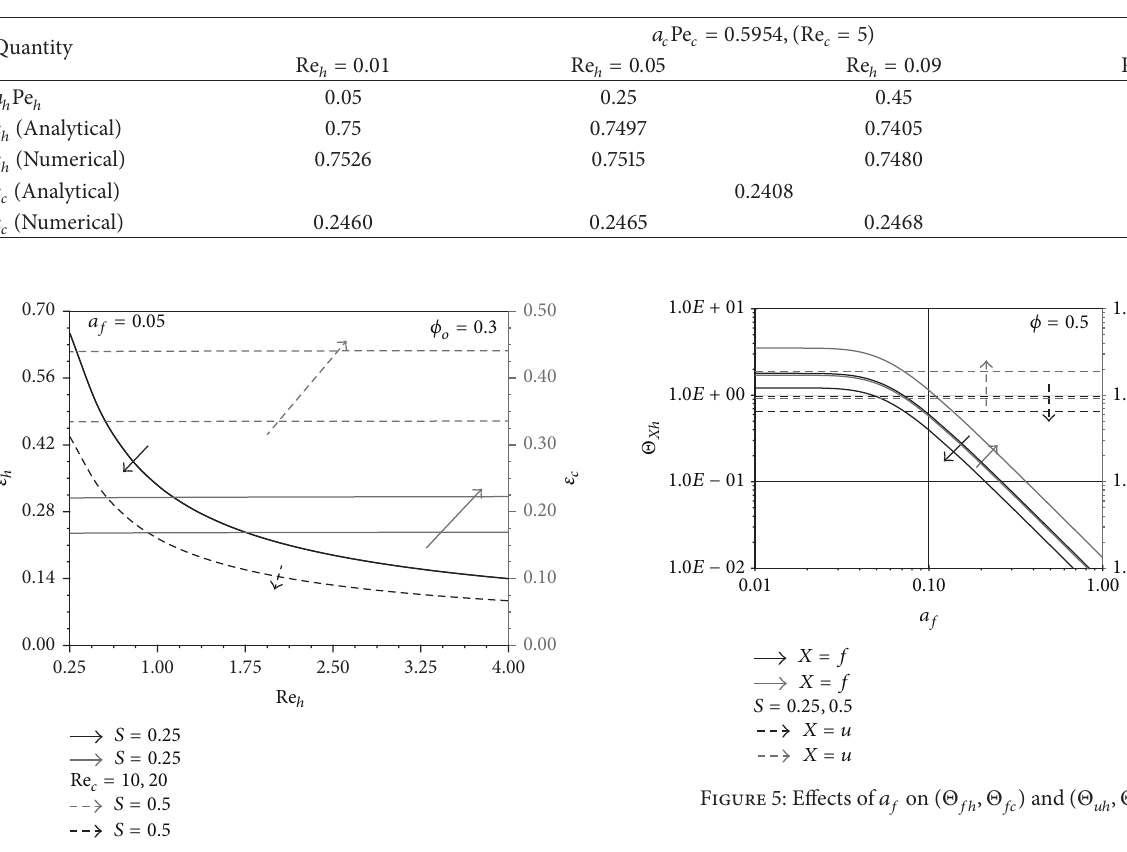
Table 2: A comparison between the numerical solution and the analytical one given by (37) and (40).